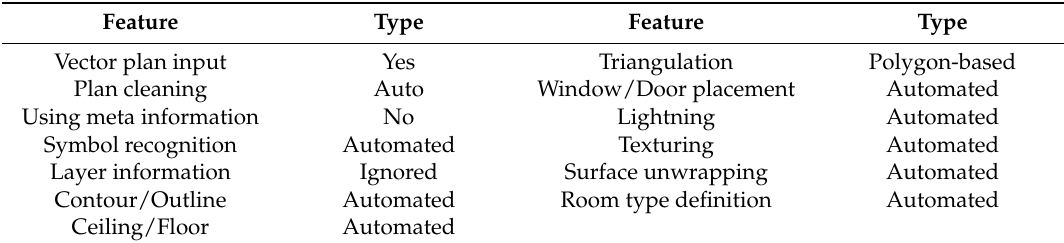
Table 2. Feature description of the presented approach.